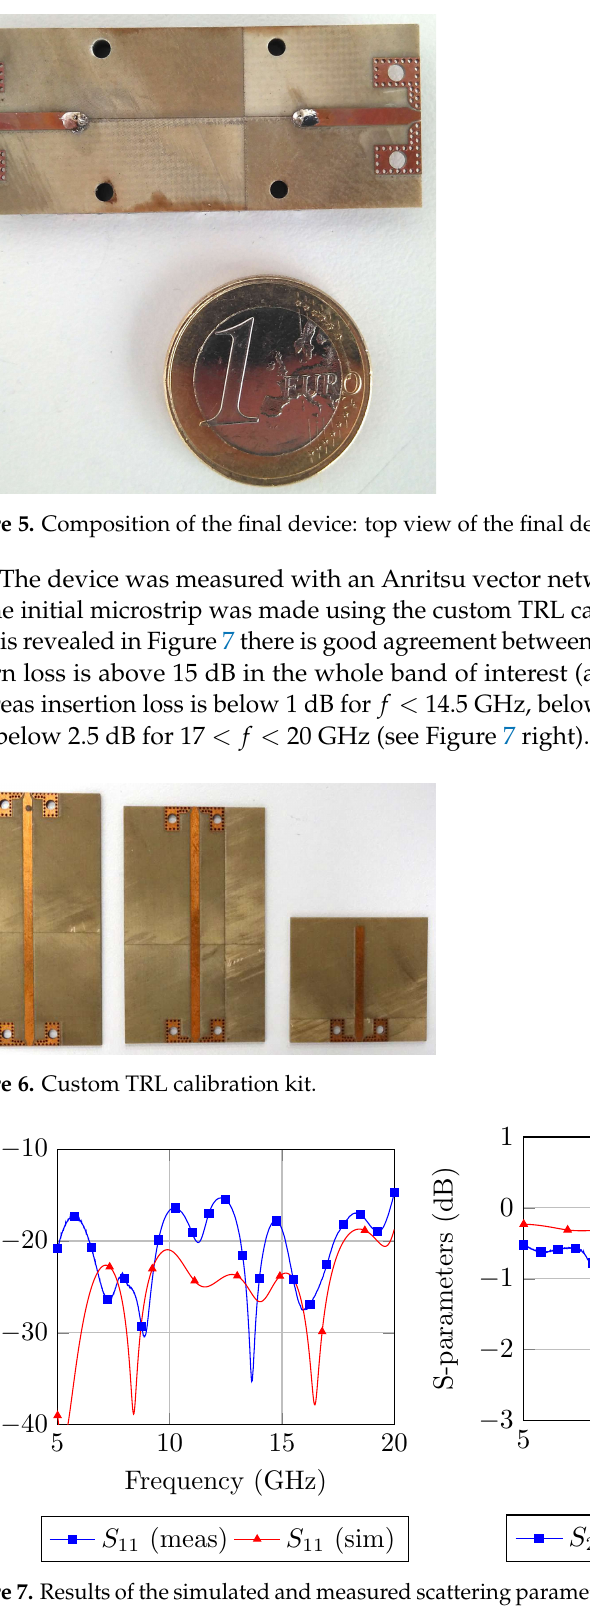
Figure 7. Results of the simulated and measured scattering parameters for the back-to-back prototype. To confirm the independence of the feeding line angle, a parametric simulation was made (considering only one transition, not the whole back-to-back). The angle was swept from 0 ◦ to 180 ◦ in intervals of 30 ◦ . Results shown in Figure 8 demonstrate the